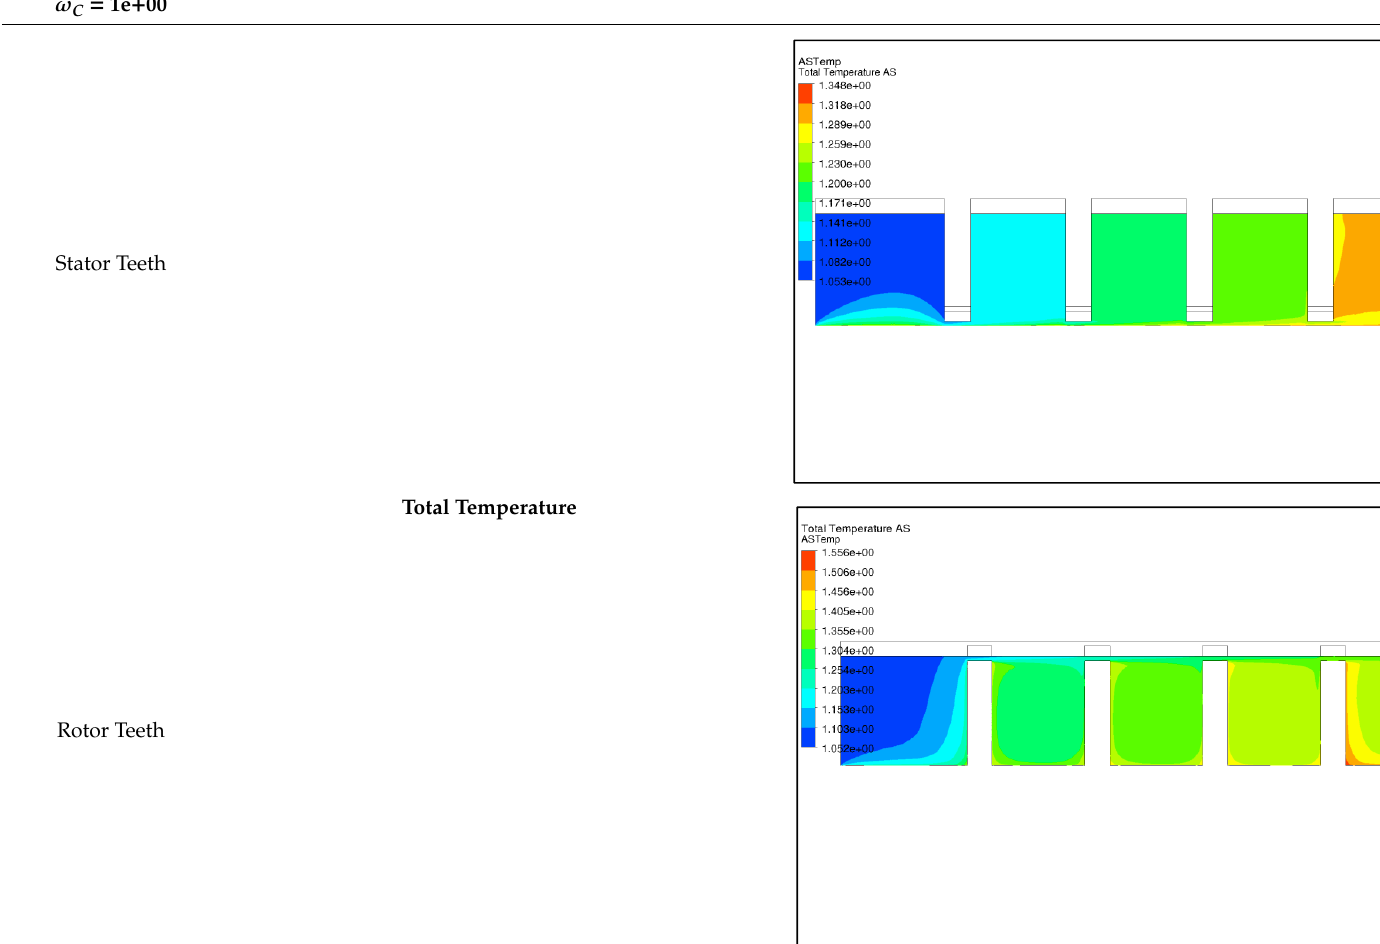
Table A5. Total temperature fields.